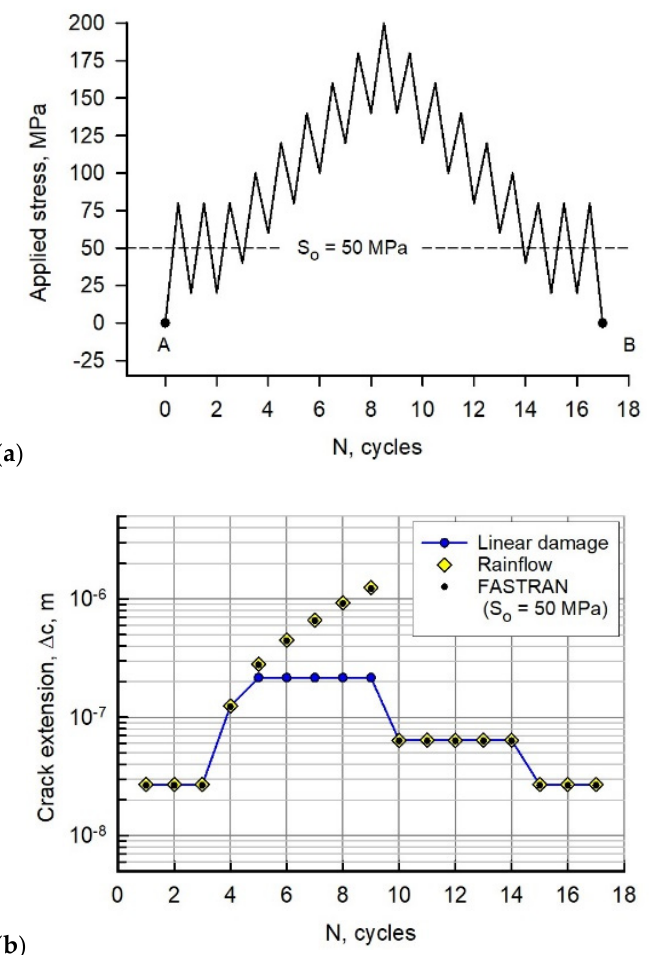
Figure 3. ( a ) Loading sequence A. ( b ) Calculated crack extension per applied cycle for load se- quence